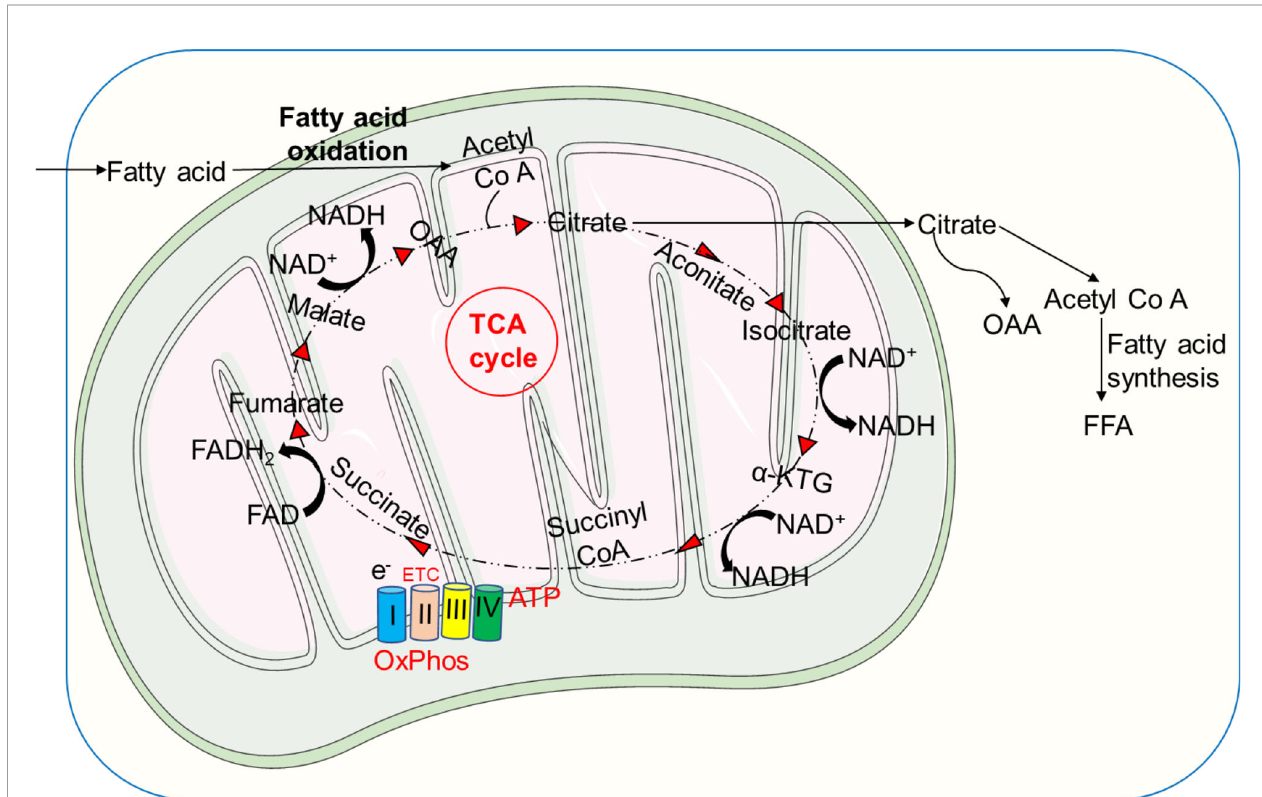
FIGURE 5 | Metabolism of fatty acids. Fatty acids are oxidized to form acetyl-Co A, which is then converted to citrate by the activity of citrate synthase. Acetyl-Co A can be also produced by the mitochondrial matrix and further oxidized in the TCA cycle. Through FAS, the TCA cycle intermediate citrate can be converted to free fatty acids (FFA), which can then be transported from the extracellular environment via the FAO pathway to produce acetyl-Co A, fueling the TCA cycle to produce signi fi cantly more energy in the form of